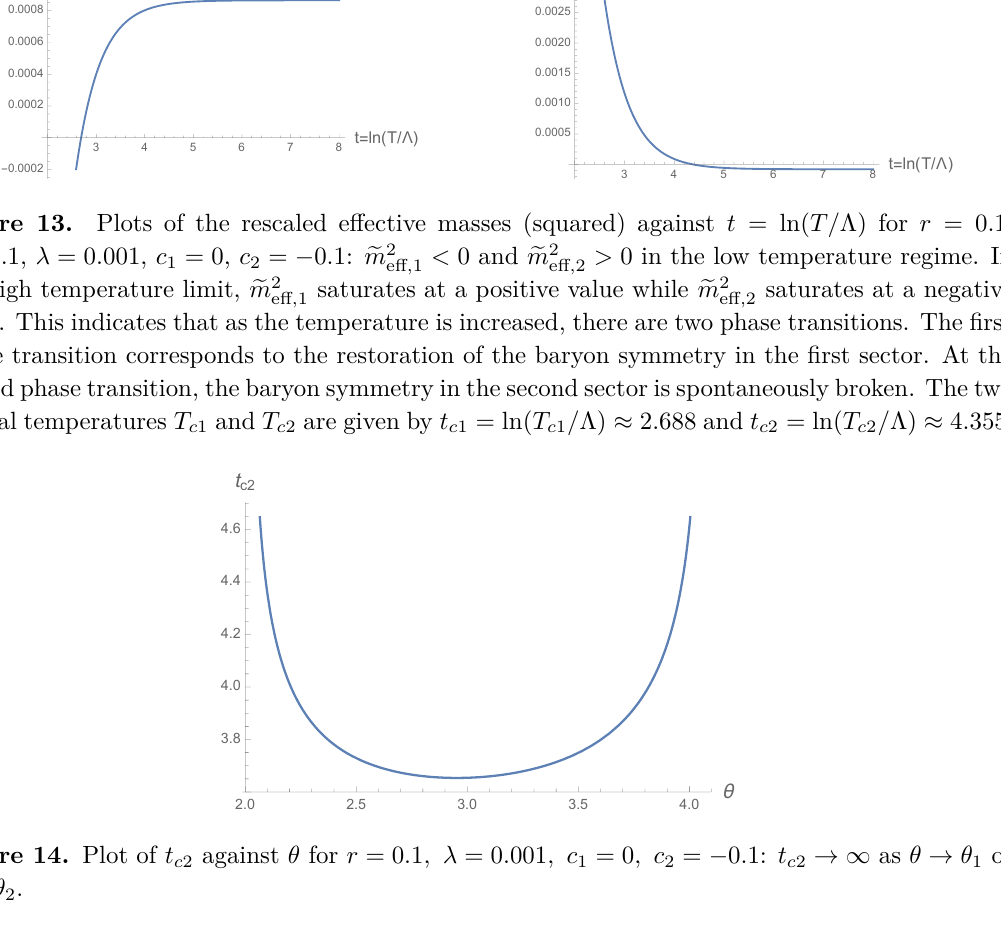
m 2 < 0 and m 2 > 0 in the low temperature regime. In e e eff , 1 eff , 2